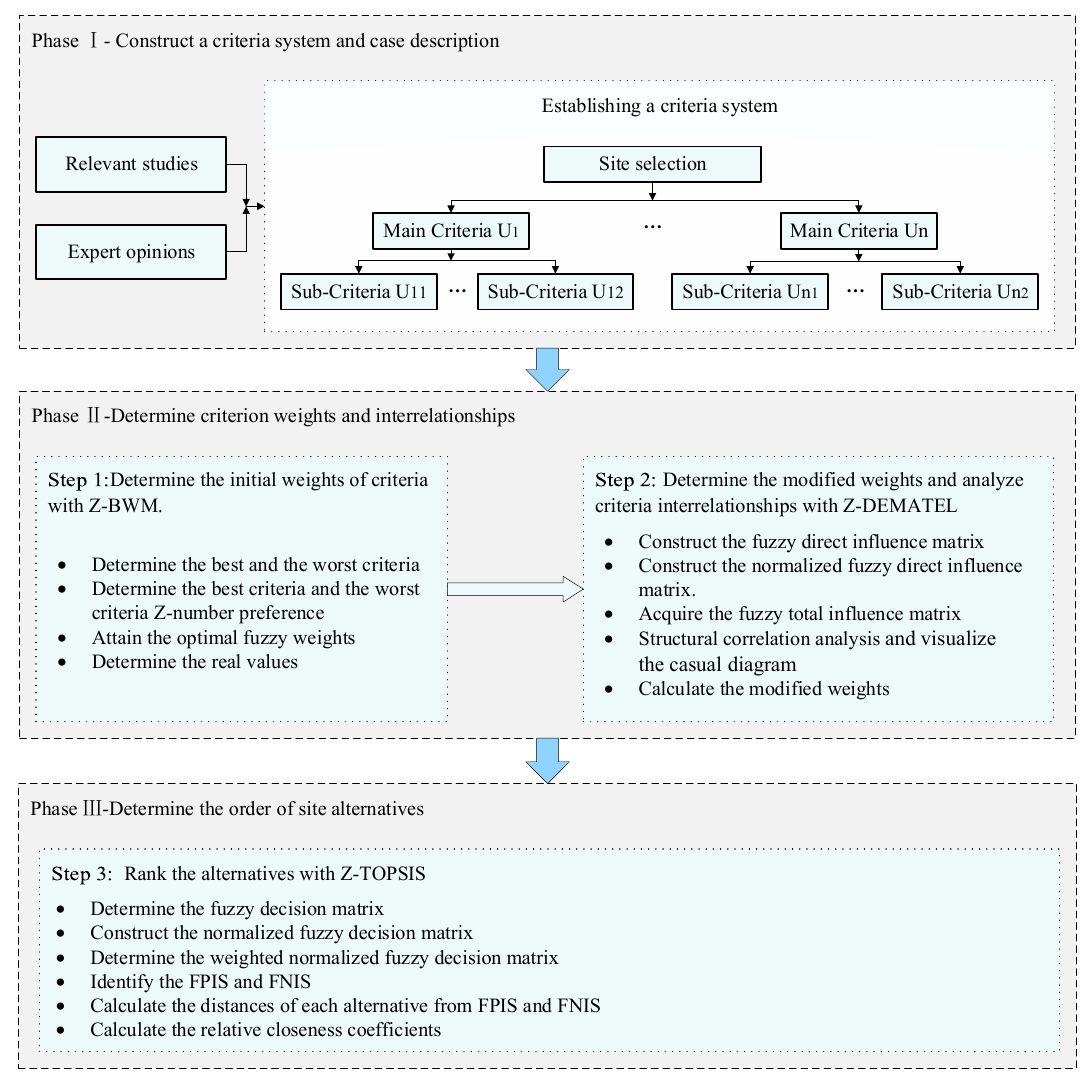
Figure 1. Multi-criteria decision support framework for inland NPP site